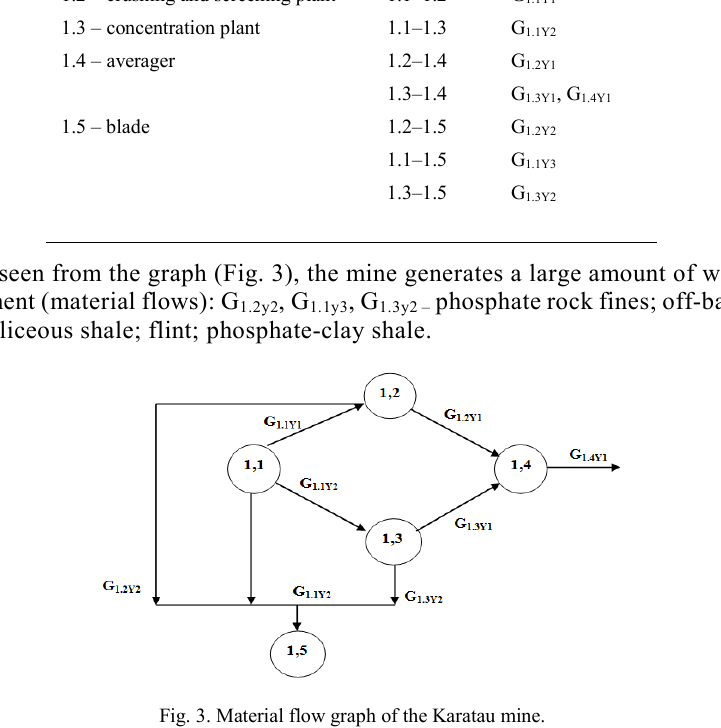
Fig. 3. Material flow graph of the Karatau